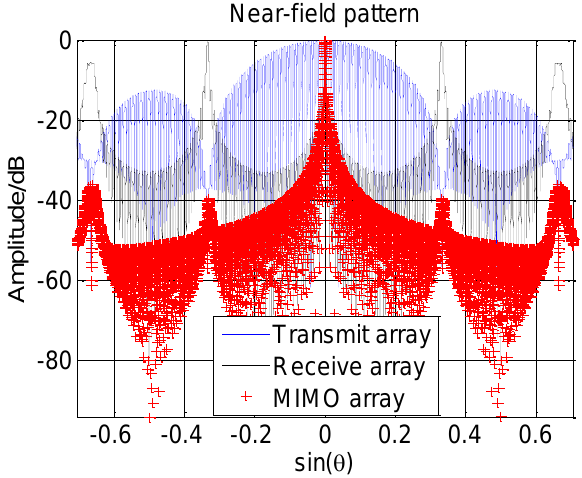
Figure 8. Grating lobes in near-field pattern of MIMO array.